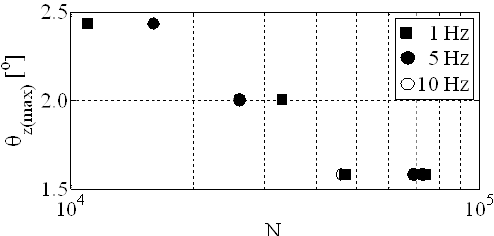
Figure 13. Maximum rotation angle against the number of cycles up to functional failure (threshold assumed at a decline of